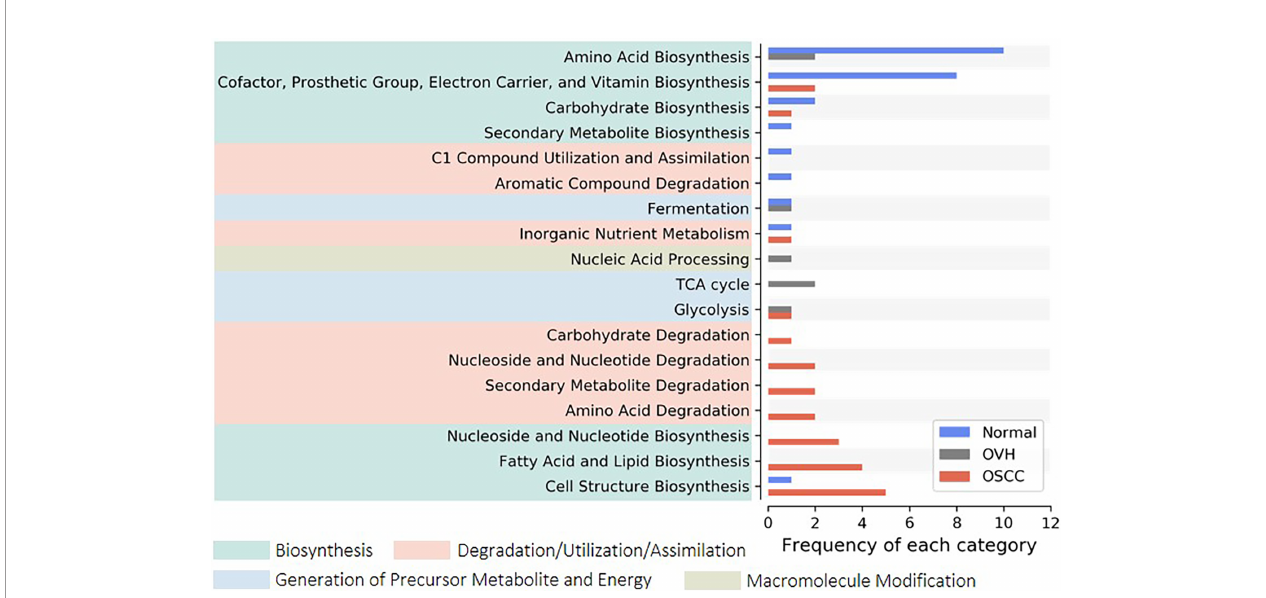
FIGURE 3 | Distribution of signature pathways. The signature pathways, which abundances are signi fi cantly higher concerning each studied cohort, are detected using LEfSe. The inferred pathways are collapsed to each category based on Metacyc ’ s pathway ontology. Colored boxes indicate a higher rank of the categories.